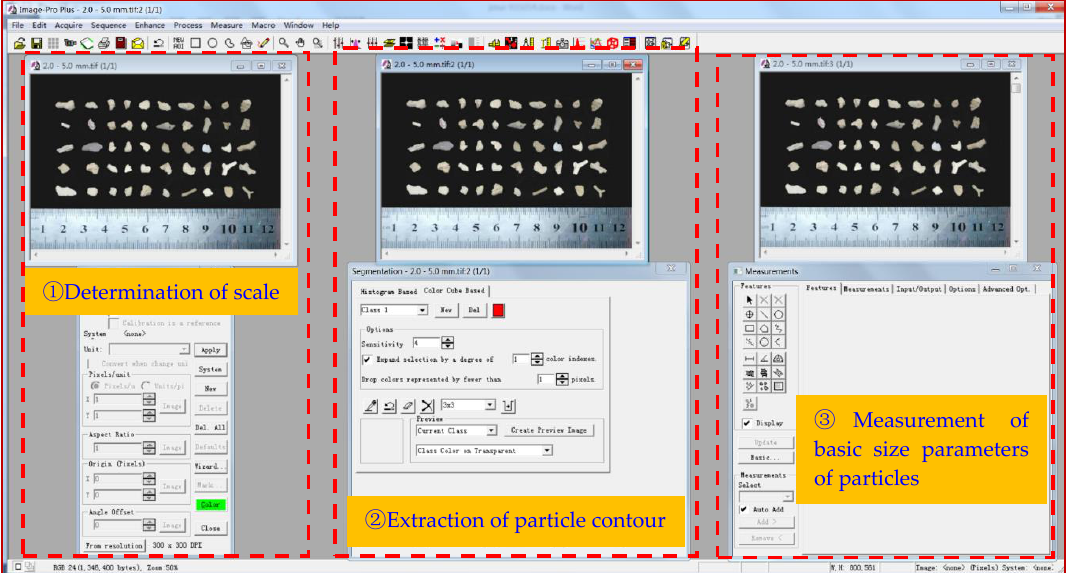
Figure 5. Digital image processing software (IPP).